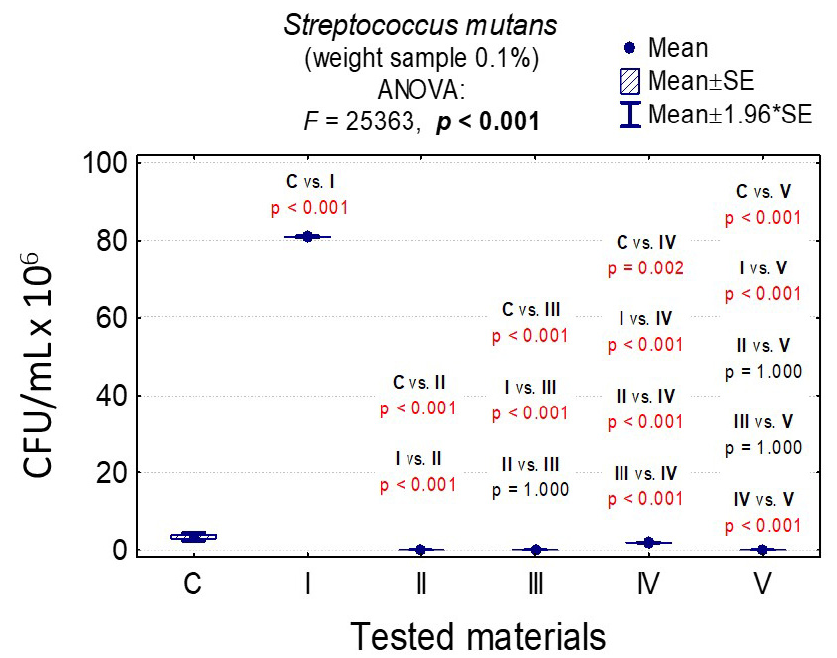
Figure 10. Average CFU/mL values and standard deviation (M ± SD) for Lactobacillus rhamnosus after temporary contact with the tested materials (C—growth control, I—nHAp, II—Cu 2+ -doped nHAp, III—nHAp with the addition of ozonated olive oil, IV—nHAp doped with Cu 2+ and loaded with ozonated olive oil, V—ozonated olive oil) for weights of 1% and results of analysis of variance (ANOVA) and multiple comparisons by a post-hoc test. Incubation took 24 h.